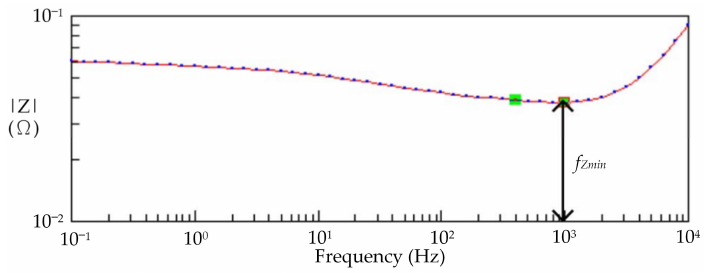
Figure 7. Relationship between the lithium-ion cell’s internal impedance with charging-current